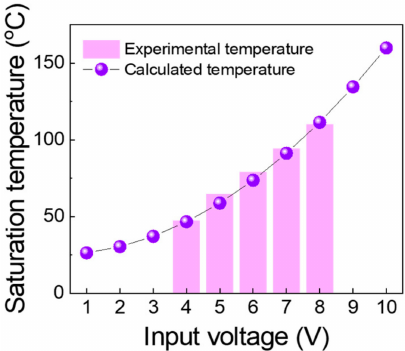
Figure 7. Calculated saturation temperature and measured saturation temperature of brush painted Ag NW network based TFHs with increasing input